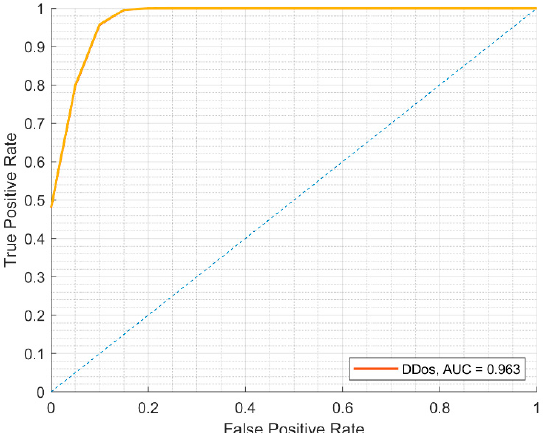
Figure 15. ROC curve of attack recognition using ML.NET created model on BOUN DDoS train- ing dataset.